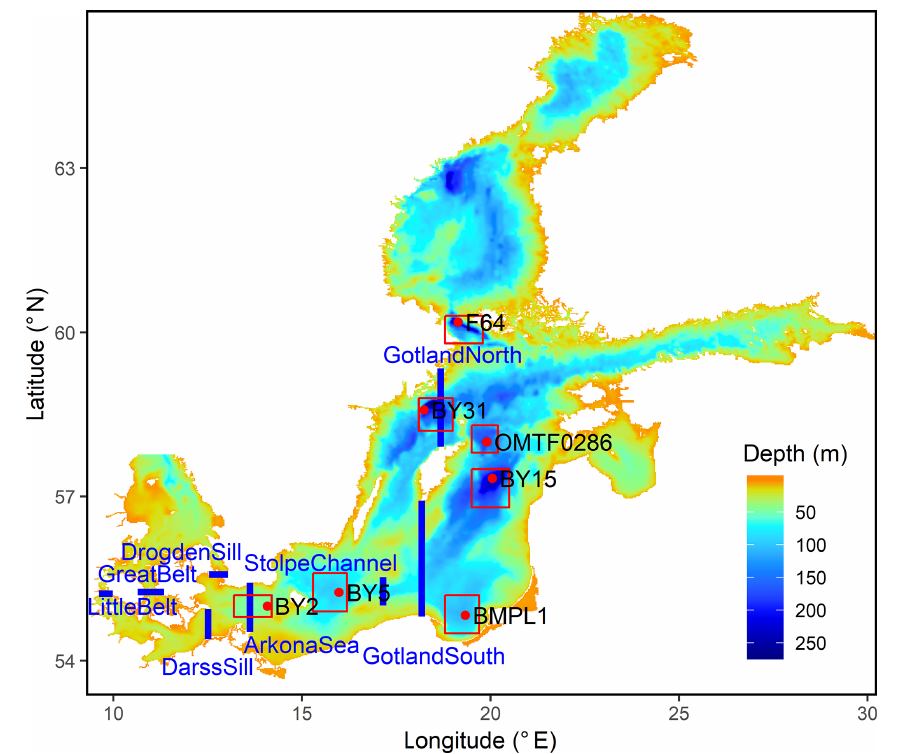
Figure 1. Model topography. Red dots: oceanographic stations. Red boxes: areas around these stations from which ICES observations were selected. Blue lines: transects across which transports were